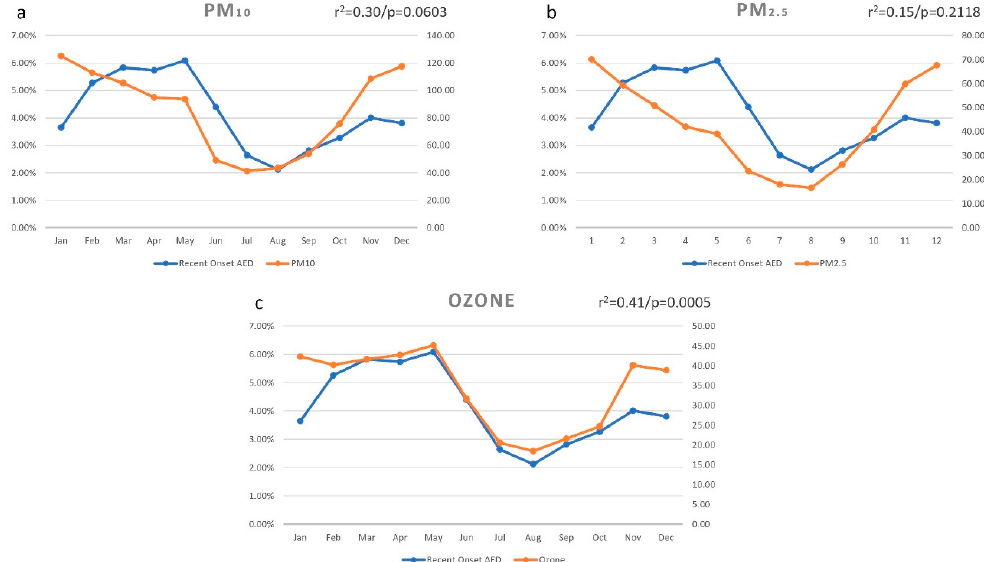
Figure 3. Monthly variation of particulate matter (PM 10 and PM 2.5 ) and ozone on the prevalence of recent onset allergic eye disease (AED) in the district of Hyderabad. The month-wise prevalence of AED was positively correlated with the distribution of PM 10 (( a ) r = 0.5563), PM 2.5 (( b ) r = 0.3887), and ozone (( c ) r = 0.8461), which was statistically significant.